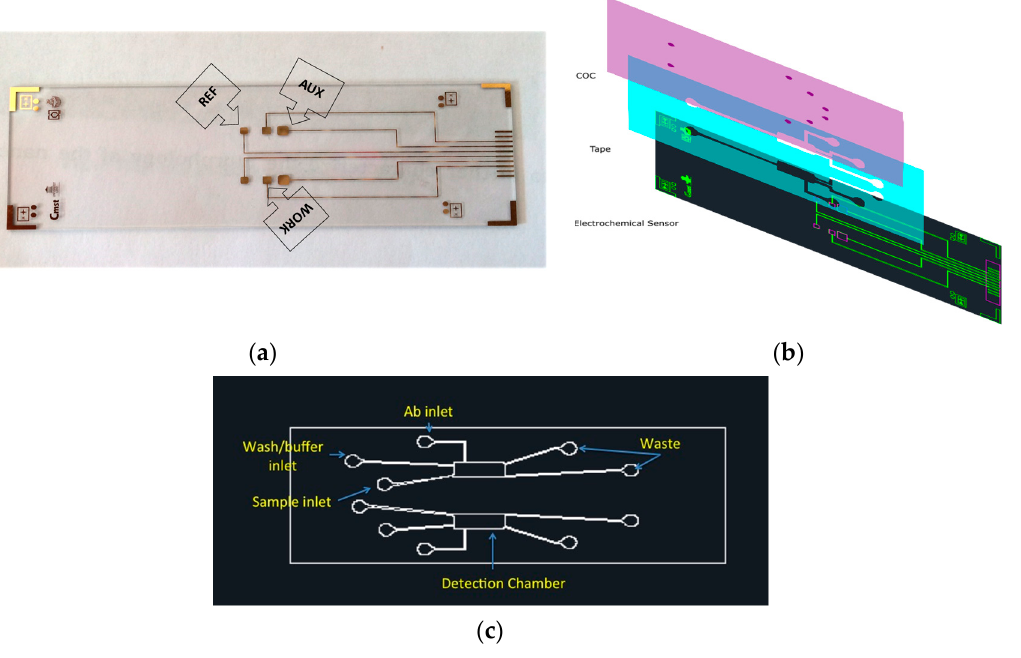
Figure 5. Diagram of the microsystem device: ( a ) schematic of the electrochemical sensor chip; ( b ) CAD design of each layer; and ( c ) the structure of the microfluidic manifold.